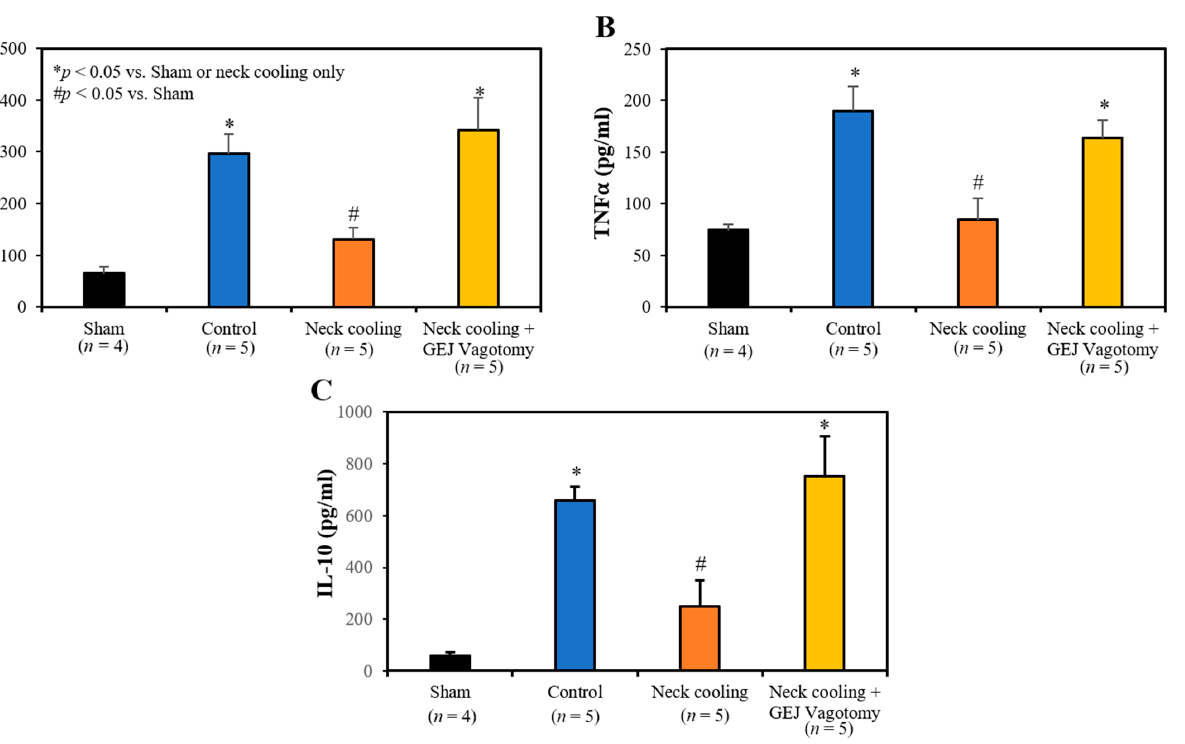
Figure 5. Kaplan–Meier survival curves after CLI without peritoneal washout ( A ) and with washout ( B ). NC: Neck cooling.